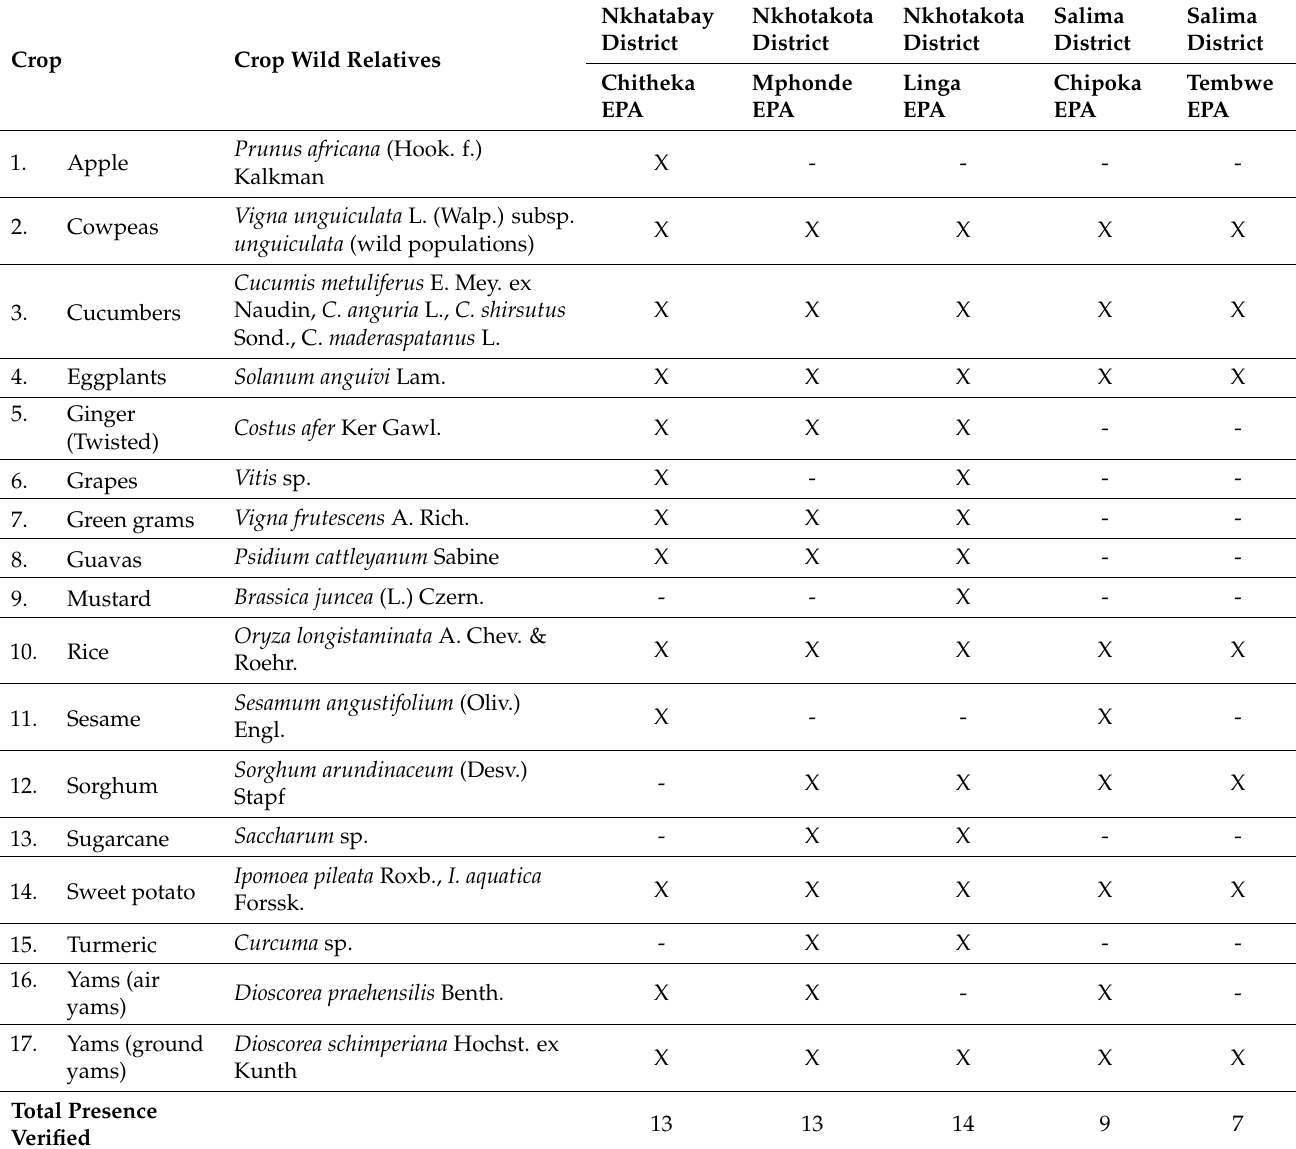
Table 2. Presence of CWRs identified by farmers in Nkhatabay, Nkhotakota, and Salima